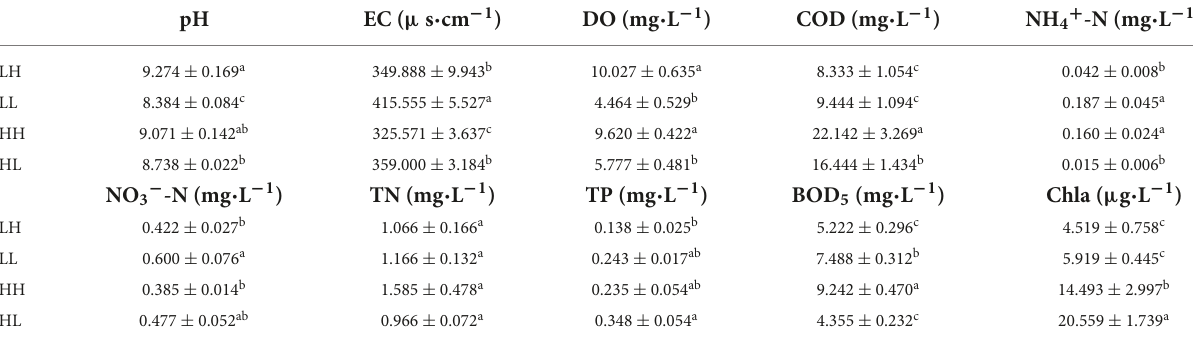
TABLE 1 Physicochemical properties (mean ± SE, n = 34) of freshwater in the four wetlands in Jiangsu,